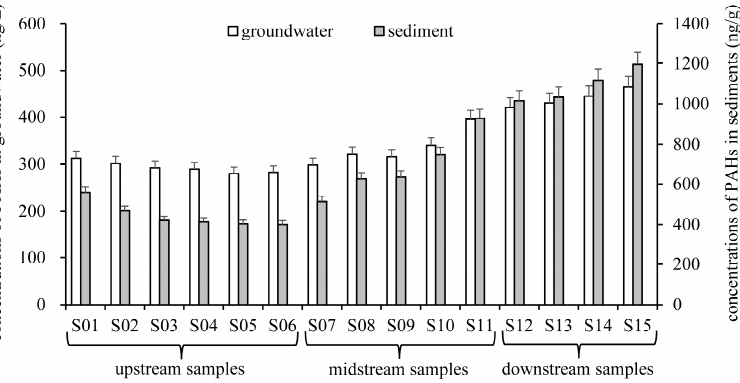
Figure 2. Distribution of concentrations of ∑ 16 PAHs in groundwater and sediments.